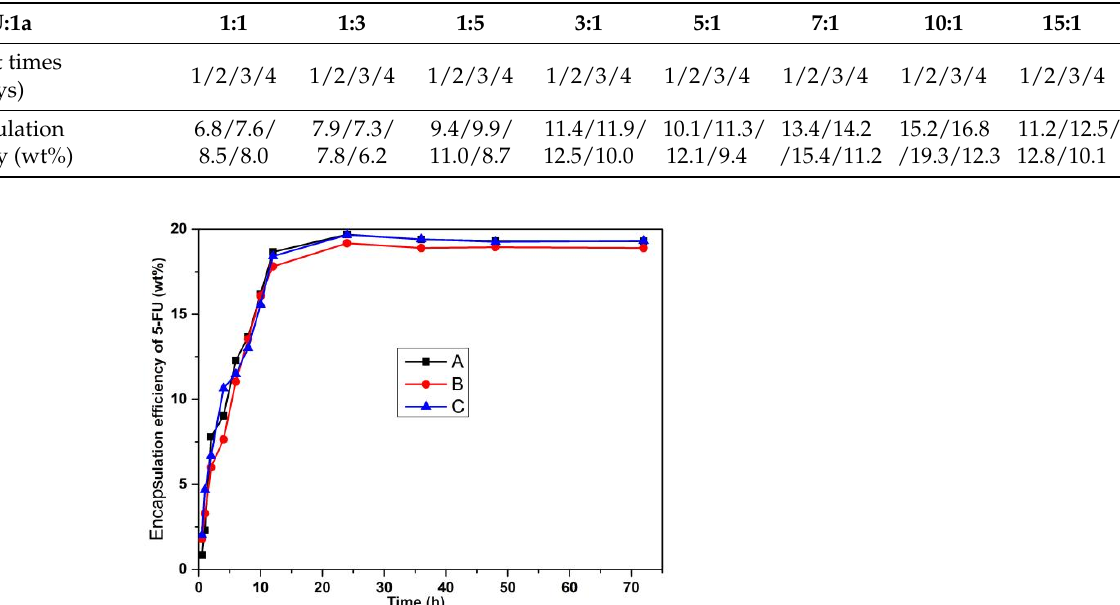
Table 1. The encapsulation efficiency of 5-FU affected by the 5-FU/material weight ratio.